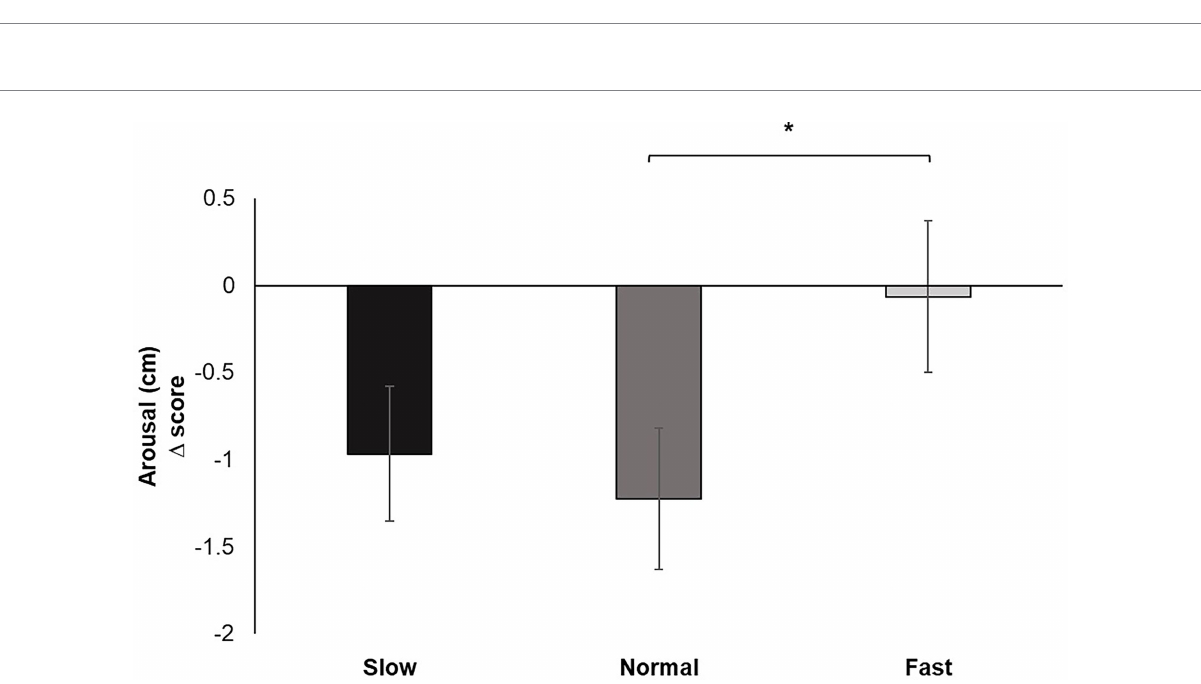
FIGURE 5 Mean perceived arousal change scores for each breathing frequency condition on a Likert scale from 1 to 9. Greater values indicate increases in perceived dyspnea of breathing to performance of the pinch task. Error bars represent +1 SE from the mean. Asterisks represent significant differences ( p <